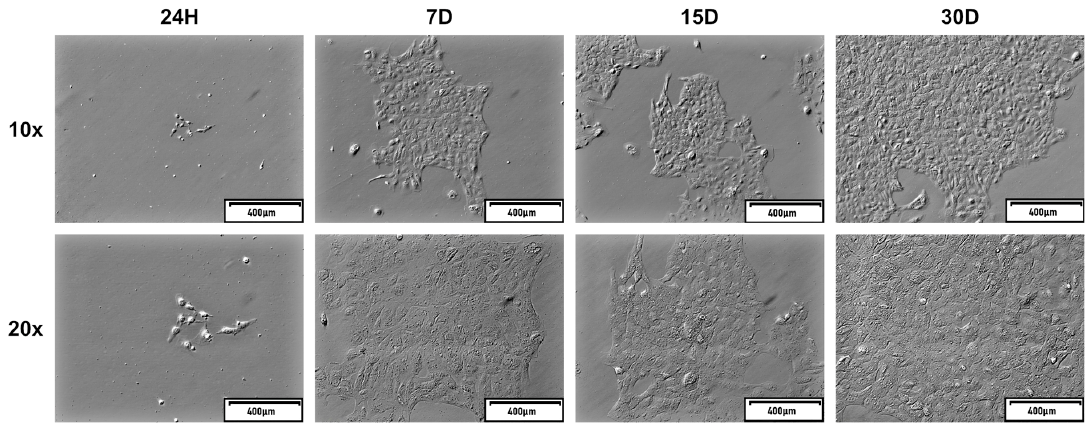
Figure 2. The representative images of oviductal epithelial cells (OECs) primary long-term in vitro culture taken after 24 h, 7, 15, and 30 days of culture using an inverted microscope with relief phase contrast.